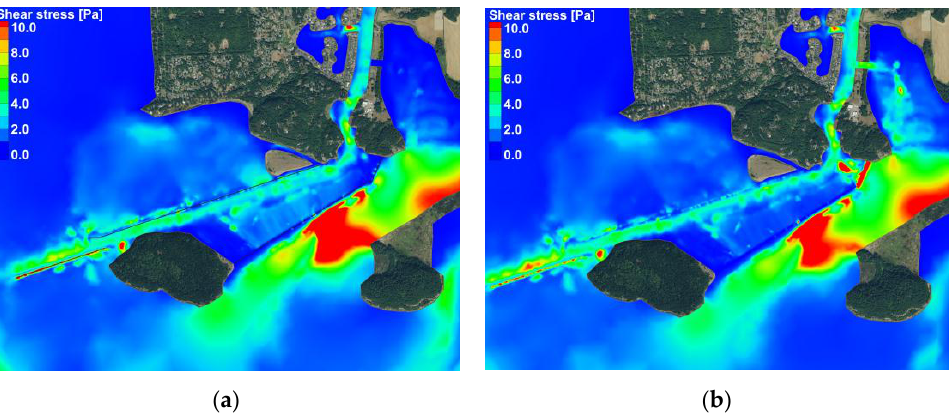
Figure 14. Time averaged bottom shear stress distribution (20 days) for ( a ) baseline conditions and ( b ) McGlinn Causeway restoration, SCN-2.